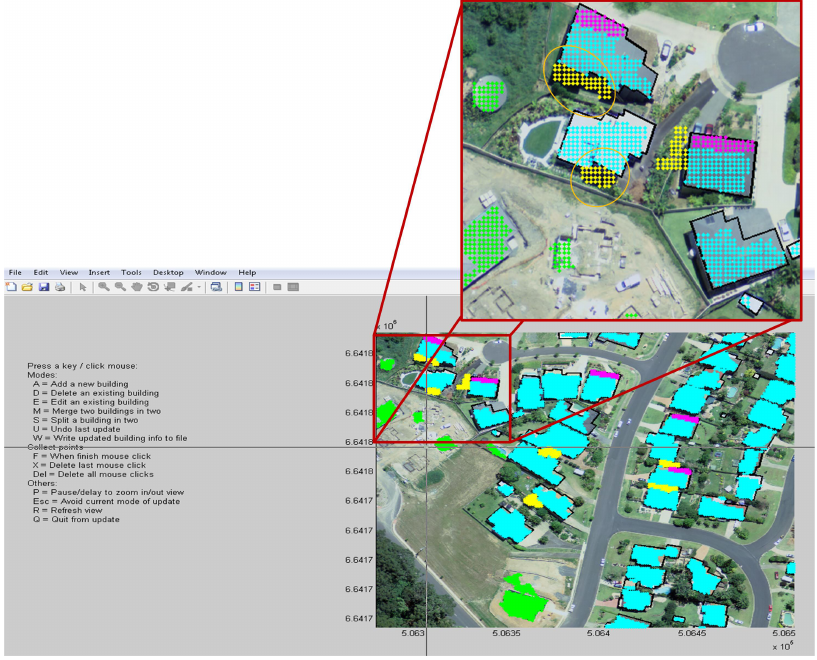
Figure 4: A simple graphical user interface (GUI) for user to update the building